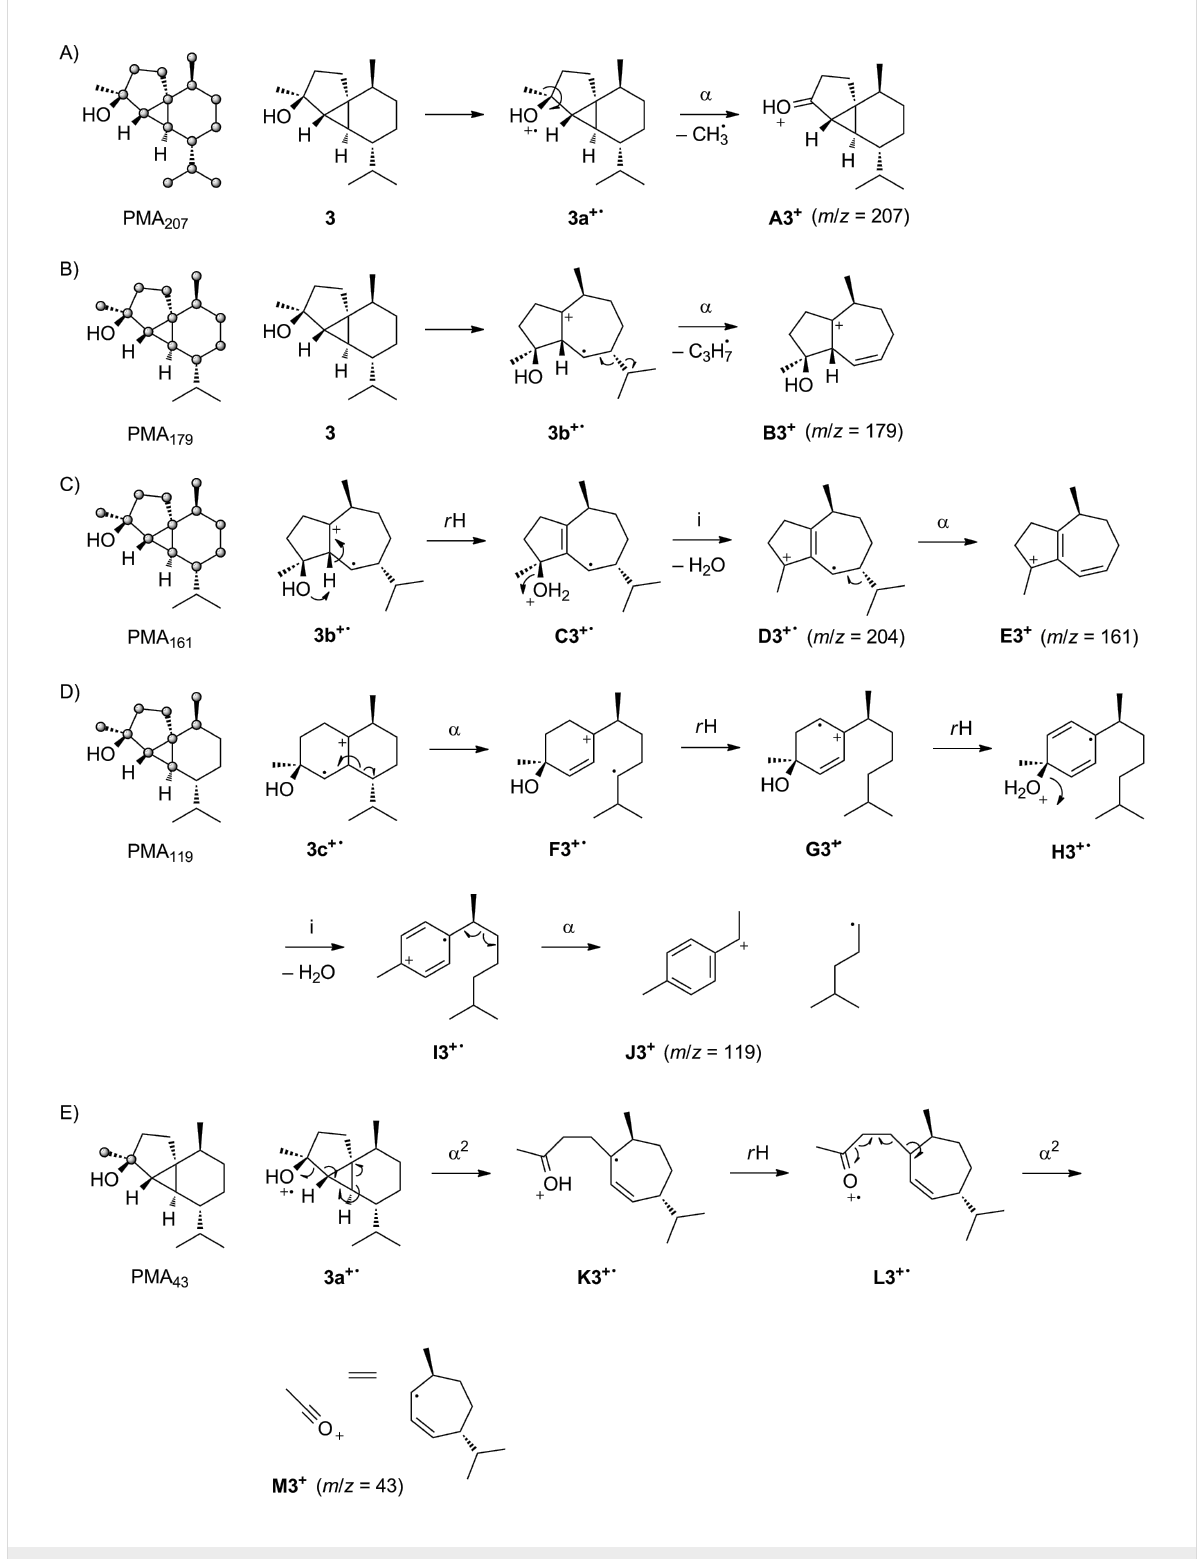
Scheme 4: PMAs and EIMS fragmentation mechanisms for the fragment ions A) m / z = 207, B) m / z = 179, C) m / z = 161, D) m / z = 119 and E) m / z = 43 of 3 . Black carbons contribute fully and red carbons contribute partially to the formation of a fragment ion. α : α -cleavage, r H: hydrogen re- arrangement, i: inductive